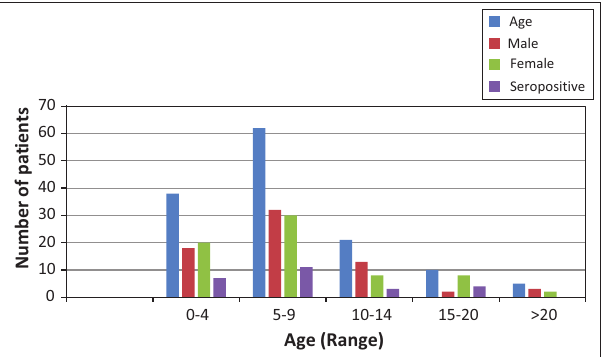
FIGURE 1: Transfused sickle cell disease patients by age, sex and seropositivity at Kenyatta National Hospital, Nairobi, Kenya, 2014.